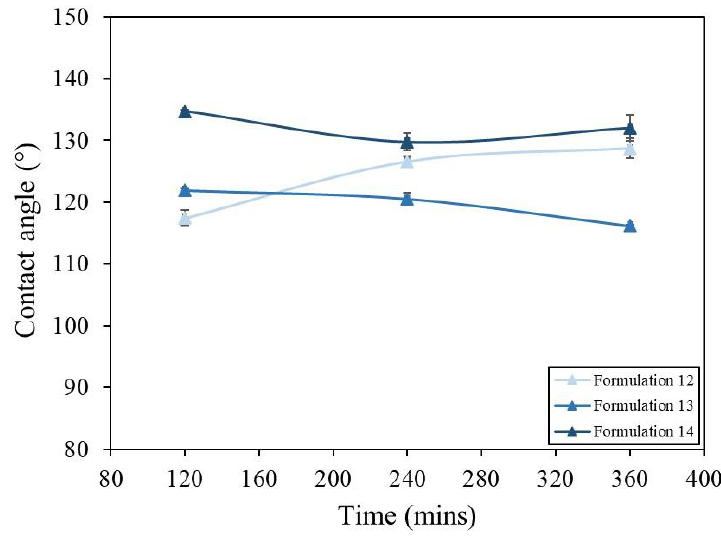
Figure 7. Relationship between CA against immersion time for formulations 12–14 from Table 1.